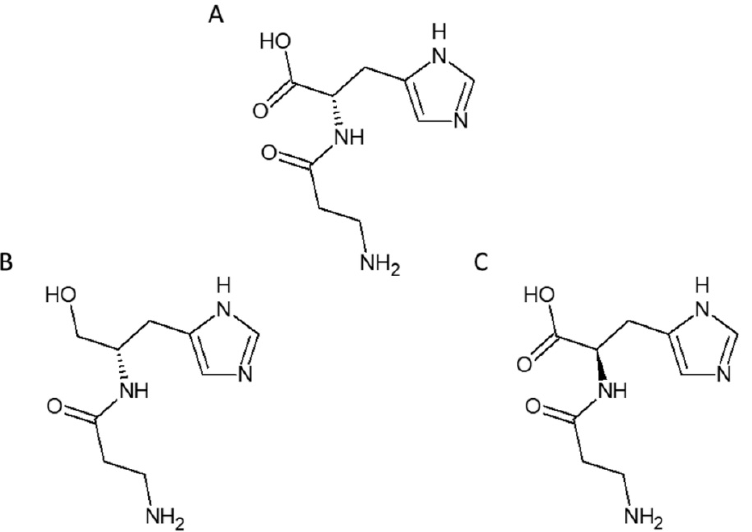
Figure 3. Carnosines with RCS scavenging activity. Chemical structure of L-carnosine ( β -alanyl-L- histidine) ( A ), the carnosinase-resistant carnosine derivative carnosinol (FL-926-16; (2S)-2-(3-amino propanoylamino)-3-(1H-imidazol-5-yl) propanol) ( B ), and the enantiomer D-carnosine ( β -alanyl-D-histidine) ( C ).